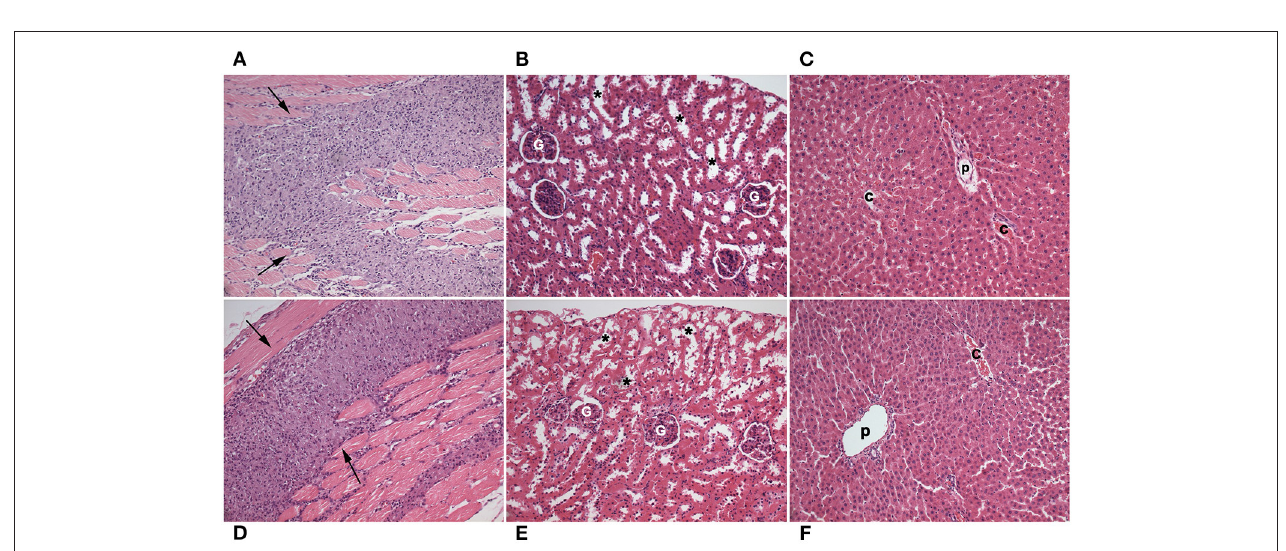
FIGURE 4 | Photomicrographs of histological sections of skeletal muscle (A) , kidney (B) , and liver (C) from Wistar rats injected with placebo, and of skeletal muscle (D) , kidney (E) , and liver (F) from rats injected with high dose of StreptInCor (200 µ g/mL). Chronic granulomatous inflammation (arrows) in skeletal muscle at the site of placebo (A) and StrepInCor (D) injections. There are not necrosis, inflammatory infiltrate, neovascularization, or fibrosis in renal or hepatic tissues. Hematoxylin and eosin staining, × 200. (G) Glomerulus; (*) proximal tubules; (p) portal tract; (c) centrilobular hepatic